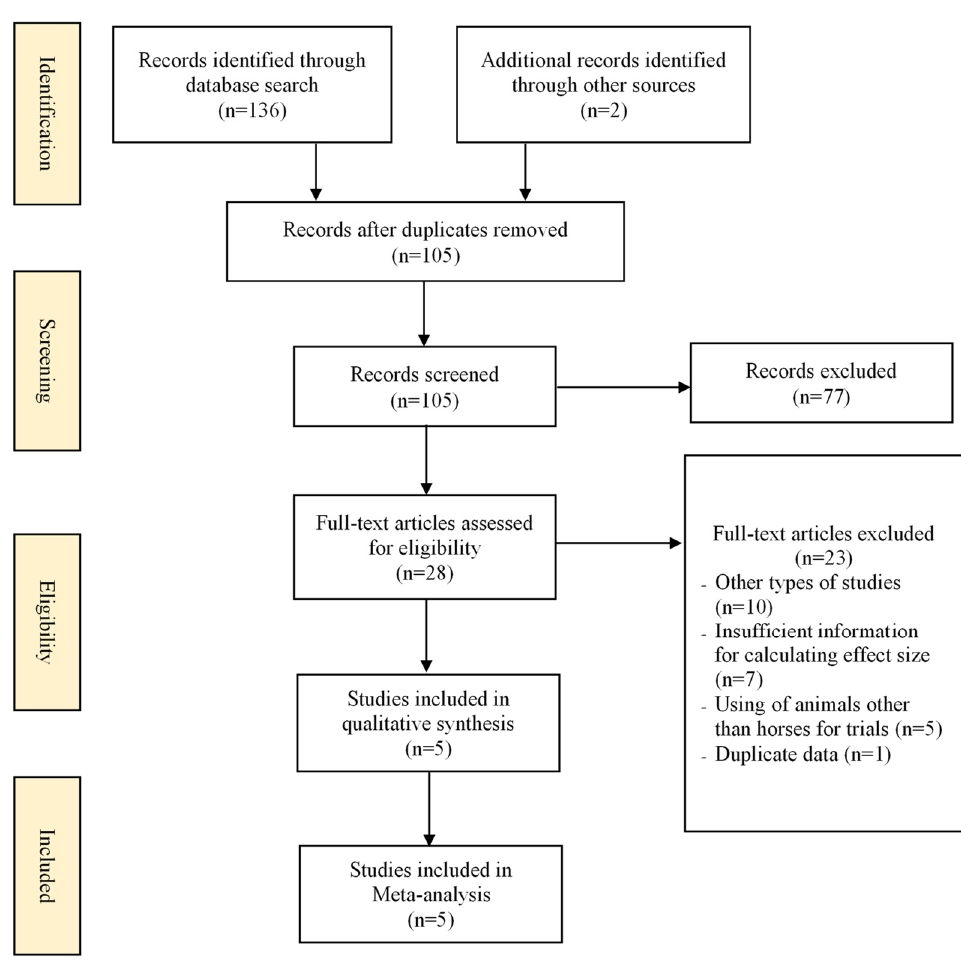
Figure 1. The flowchart of the study selection process.